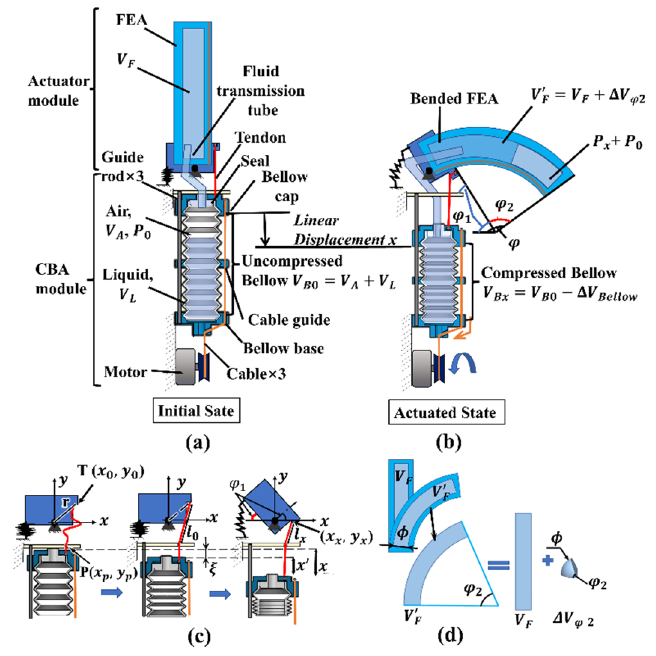
Figure 3. Design and modeling of the DASA. ( a ) Schematic of the DASA. ( b ) The DASA at a bending state. ( c ) Modeling of the tendon-driven MCP joint. ( d ) Modeling of the FEA inner chamber volume change in bending.